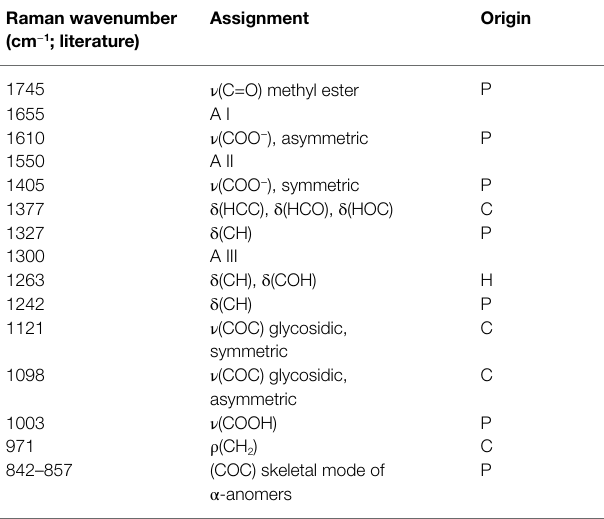
TABLE 1 | Assignment of bands in the Raman spectra of cell wall polysaccharides. Raman wavenumber (cm − 1 ;